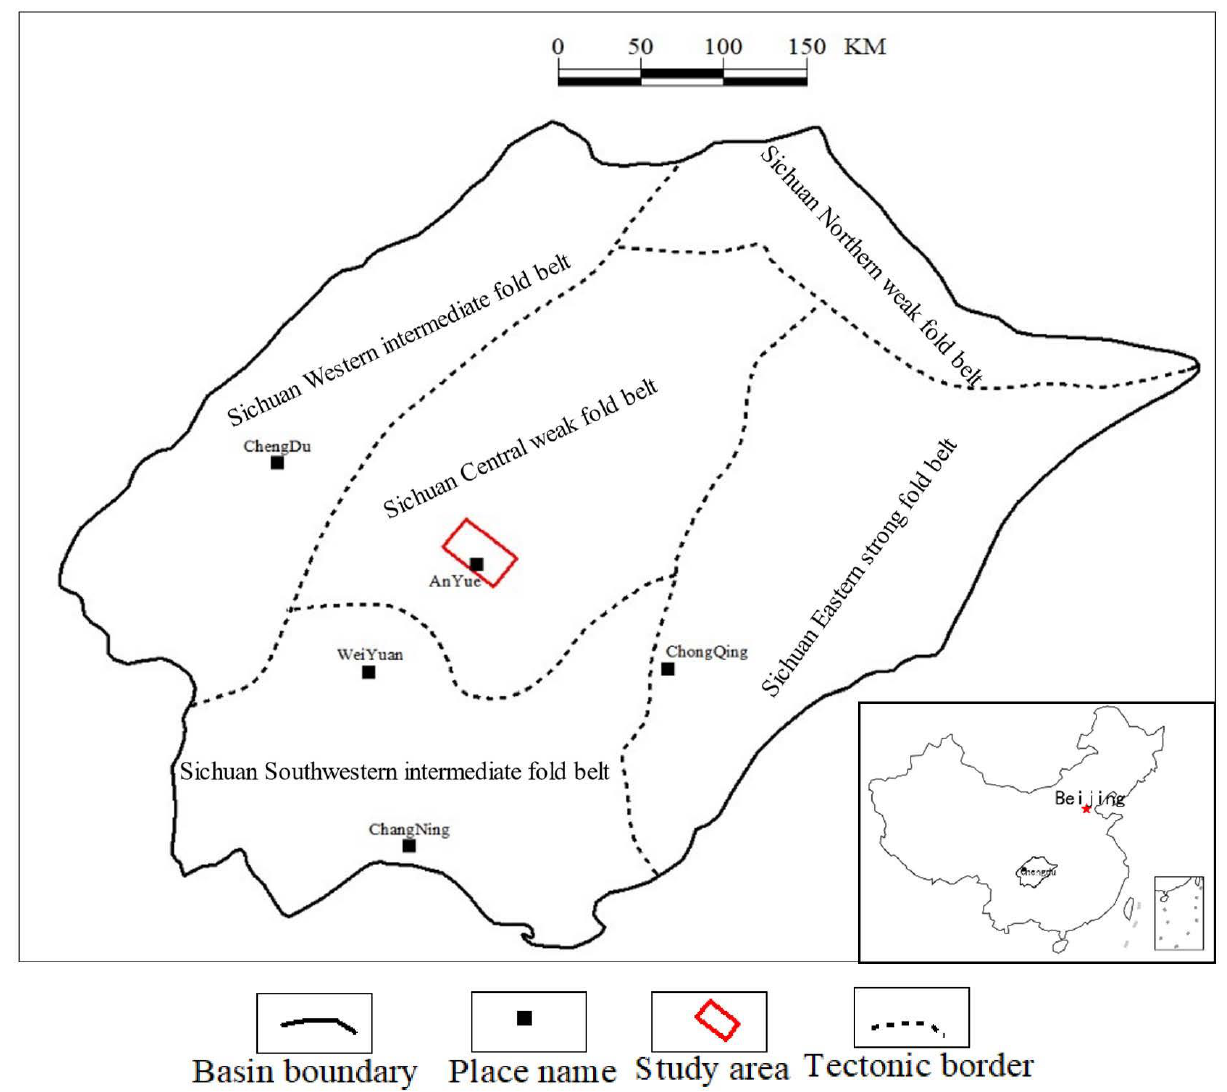
Figure 1. Regional tectonic background and location of the study area in the Sichuan central weak fold belt. The study area of Anyue Gas Field is a reputable gas field in